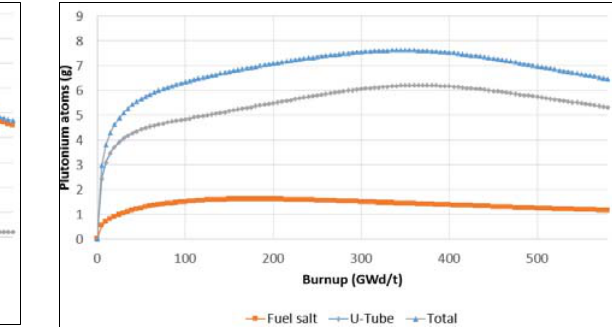
Figure 26. Plutonium build up versus burnup at =540cm); Zero-diffusion ϒ=69% (h c